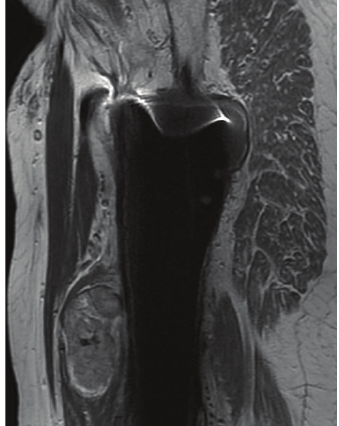
Figure 5: Sagittal T1-weighted MR image. The lesion is well defined at the prosthesis bone